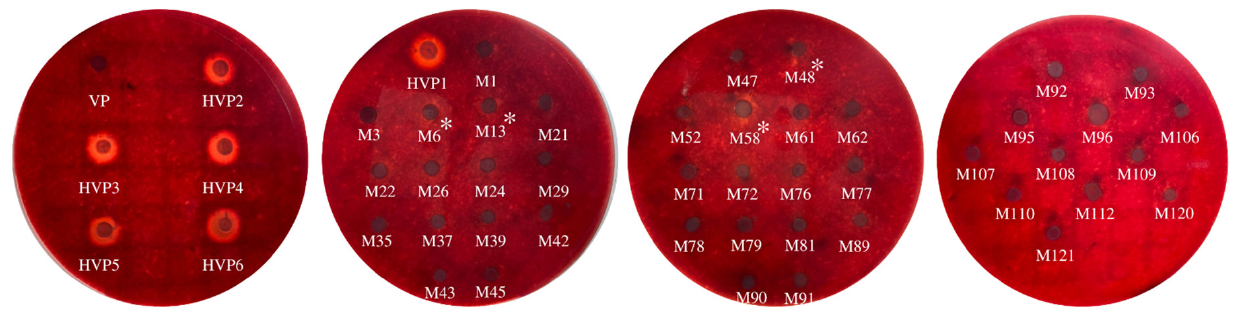
Figure 4. The hemolytic activity of V. parahaemolyticus isolates against RBCs. β-hemolysis zone surrounding the spot of growth on the Wagatsuma agar plate was measured. V. parahaemolyticus cells were grown on Wagatsuma agar for 24 h. * Isolates with weak hemolysis.